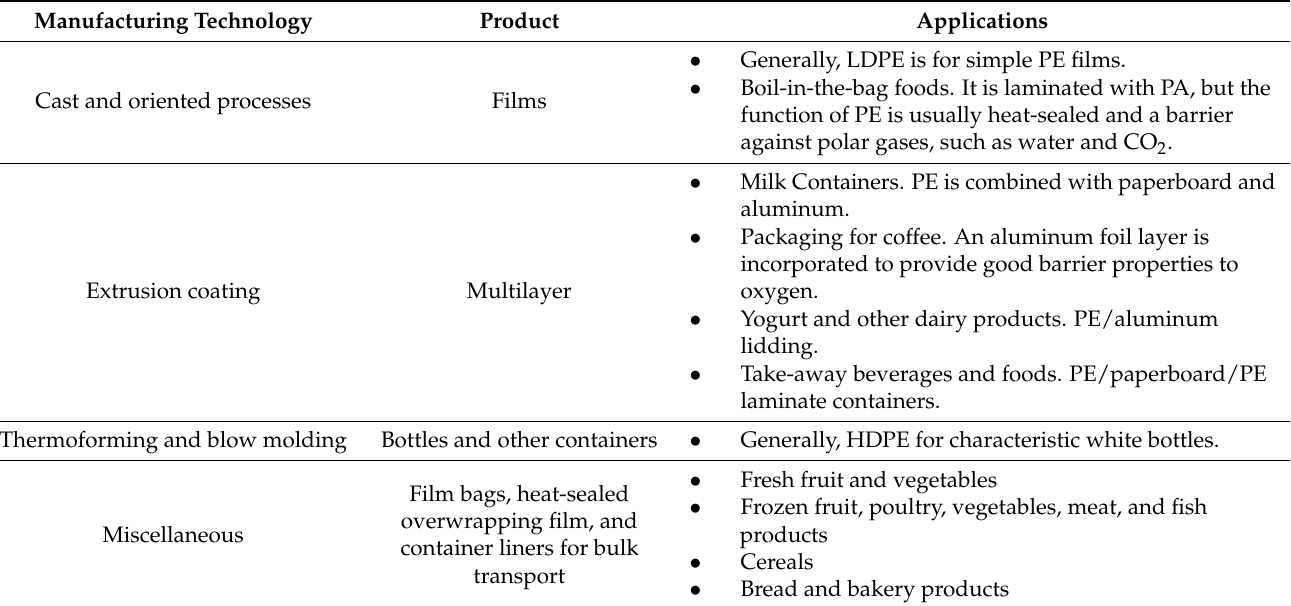
Table 6. Application for PE-based products and manufacturing technology